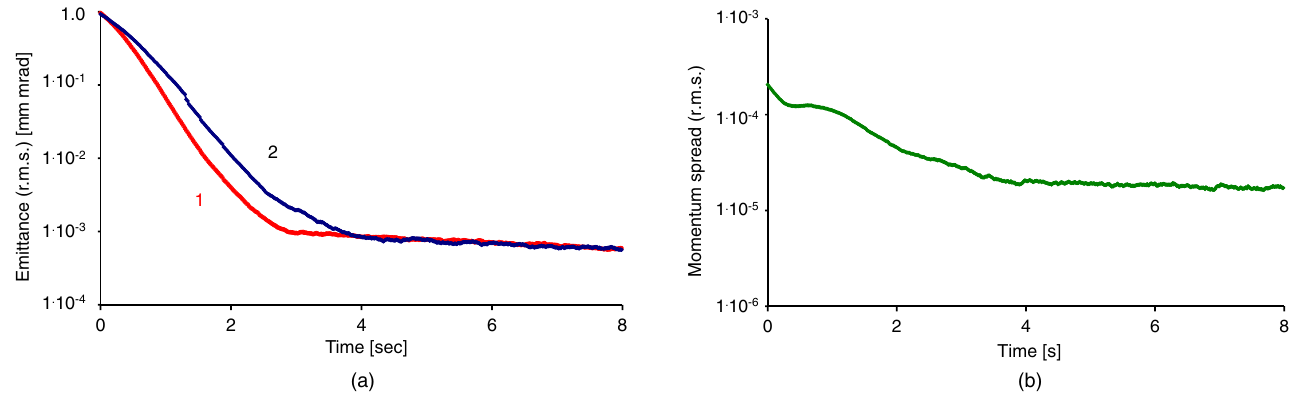
FIG. 14. Kinetics of 93 keV = A CF þ ions in the TSR ring: (a) shrinking of horizontal (1) and vertical (2) beam emittance by (cid:8) 1000 times; (b) decrease of the momentum spread to equilibrium at ð (cid:1) p=p Þ